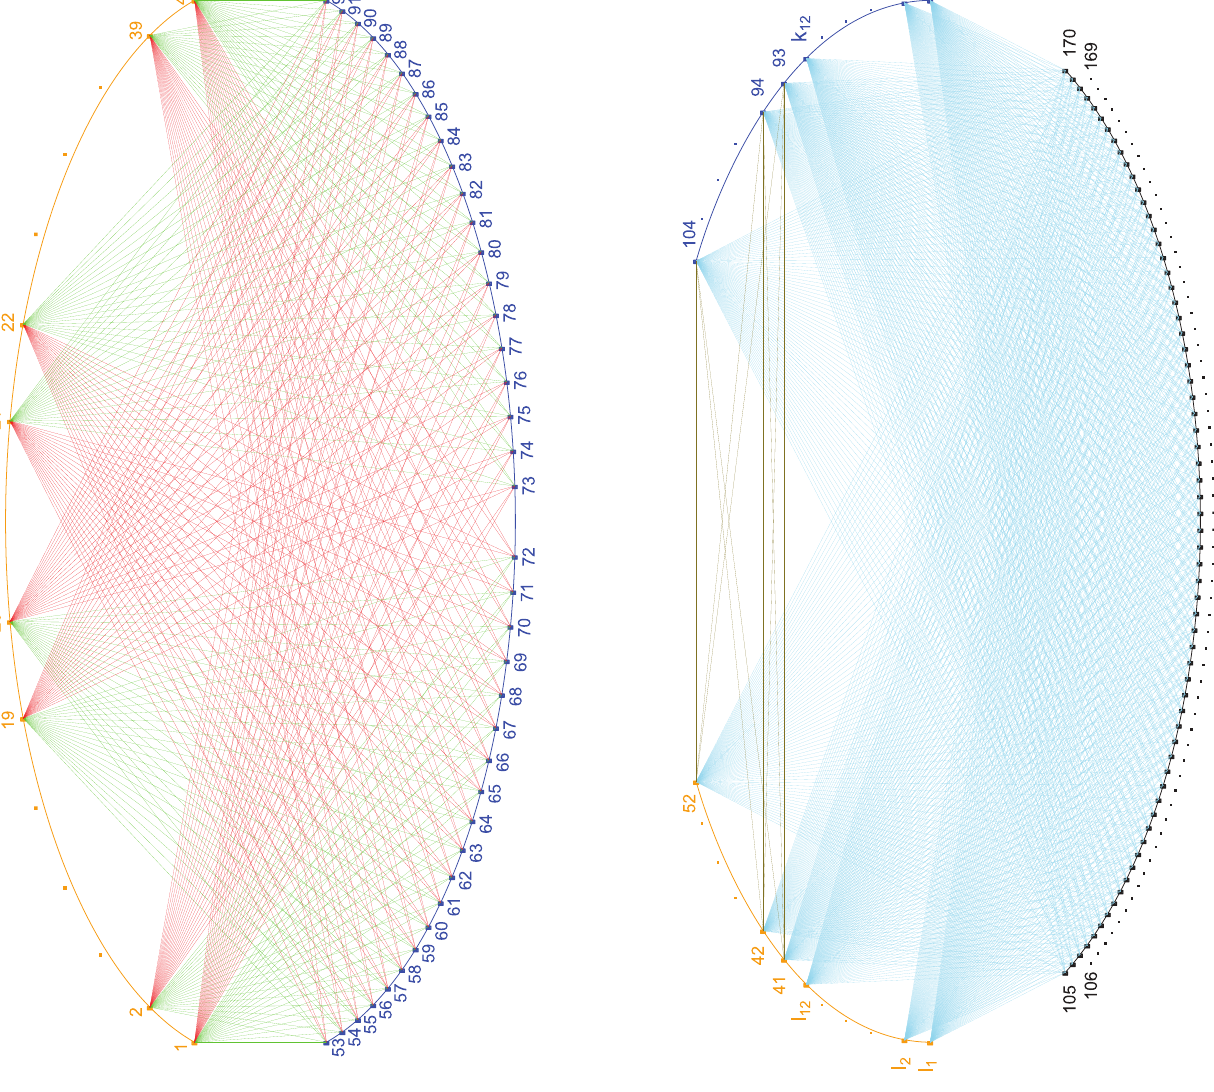
Figure 1. Illustration of sampling probabilities for simulated data set one. Left figure: Pair set one. All orange points (fragments 1–40) are connected to all blue points (fragments 53–92), either by green lines or by red lines. Fragments 1–20 and fragment 53–72, also fragments 21–40 and fragments 73–92, are connected by green lines. Other lines are red. All pairs in this graph were designated as true pairs in the simulation for data set one and the ratio of the sampling probabilities for a green line to that for a red line is 2:1. Right figure: Pair set two. All orange points (fragments 41– 52 and fragments l 1 2 l 12 ) and all blue points (fragments 93–104 and fragments k 1 2 k 12 ), are connected to all black points (fragment 105–170) by sky- blue lines. Fragments 41–52 are connected to fragment 93–104 by gold lines. All pairs in this graph were designated as false pairs in the simulation for data set one and were assigned the same sampling probability. The ratio of the sampling probabilities for a green line, to that for a red line, and to that for a sky-blue/gold line is 6:3:1.